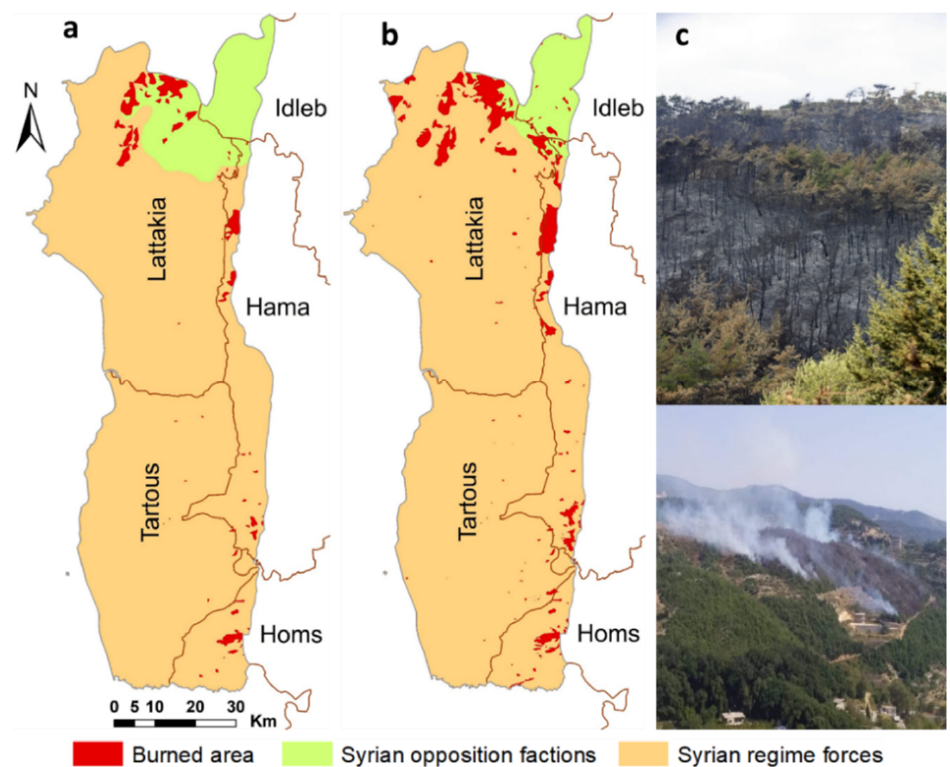
Figure 9. Burned forest areas in the Syrian coast region for 2015 ( a ), 2020 ( b ), and fires of oaks ( Quercus ) and Aleppo pine ( Pinus halepensis ) forests adapted from [64] ( c ).